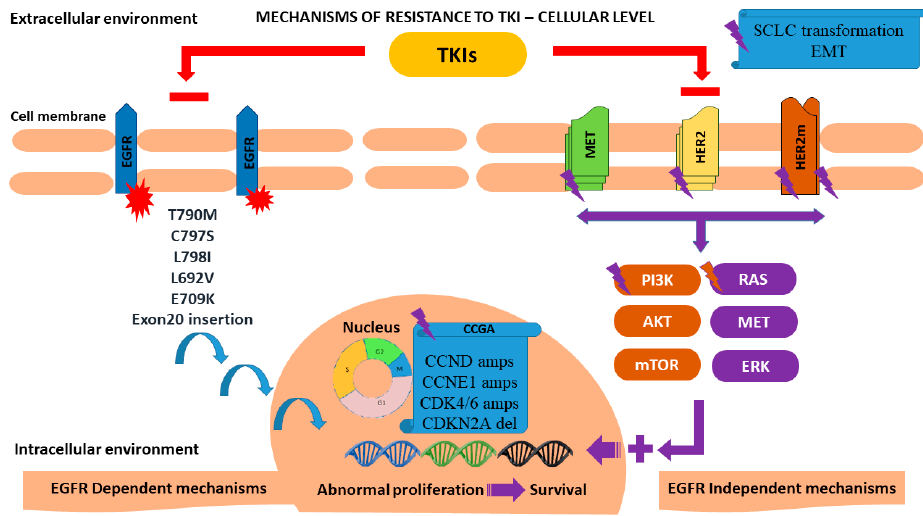
Figure 2. Mechanisms of resistance to EGFR-TKIs from a cellular perspective. Schematic representation of EGFR-dependent and independent mechanisms of resistance to TKIs. Stars and lightings illustrate protein mutations in the EGFR dependent and independent sides, respectively, red arrows represent inhibitory effects and purple and blue arrows depict activating effects. Resistance to TKIs decreases their inhibitory effect on intracellular signaling cascades associated with abnormal cell proliferation. EGFR: Epidermal Growth Factor Receptor, TKIs: Tyrosine Kinase Inhibitors, CCGA: Cell Cycle Gene Alterations, CCND amps: Cyclin D1 and Cyclin D2 genes amplifications, CCNE1: Cyclin E1 gene amplification, CDK4/6 amps: Cyclin-Dependent Kinase 4 and 6 genes amplification, CDKN2A: CDK inhibitor 2A, SCLC: Small Cell Lung Cancer, EMT: Epithelial Mesenchymal Transformation.